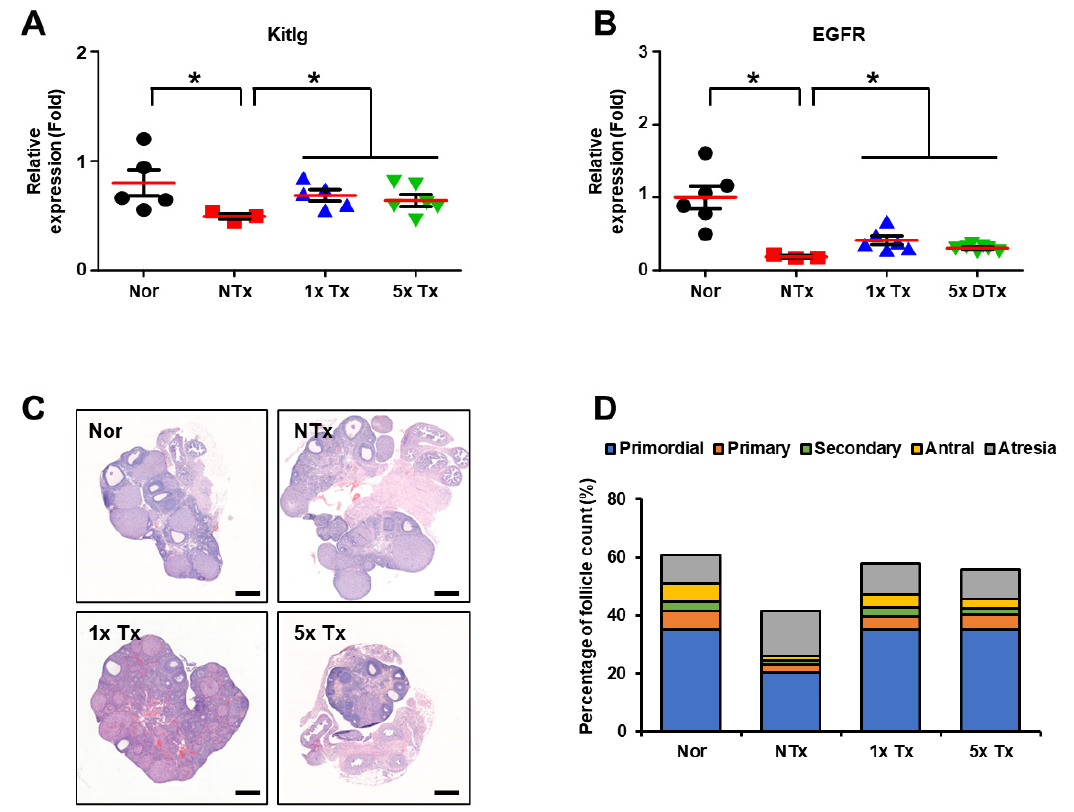
Figure 4. Effect of a low dose of PD-MSCs on follicular development in the ovaries of rats with ovarian dysfunction. ( A ) The mRNA expression levels of Kitlg and ( B ) EGFR were analyzed by qRT-PCR. ( C ) Histological analysis of follicular development in the ovary was analyzed by H&E staining. ( D ) The follicle count according to follicular development was analyzed by the 3D HISTECH program. Scale bar: 500 µ m; magnification: 2 × . The data are representative of three independent experiments and expressed as the mean ± S.D. Statistical significance was determined by using one-way ANOVA, * p <